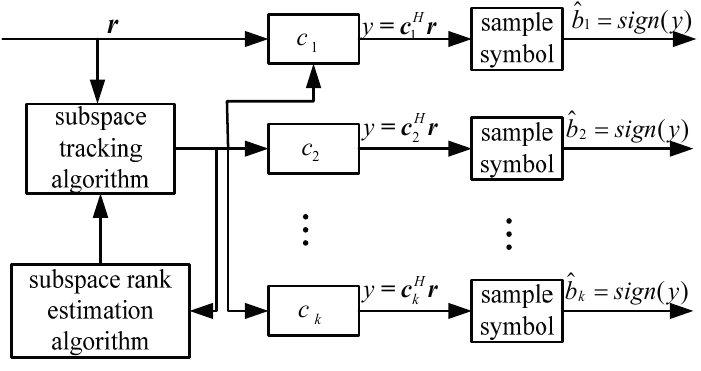
Figure 1. Blind adaptive multi-user